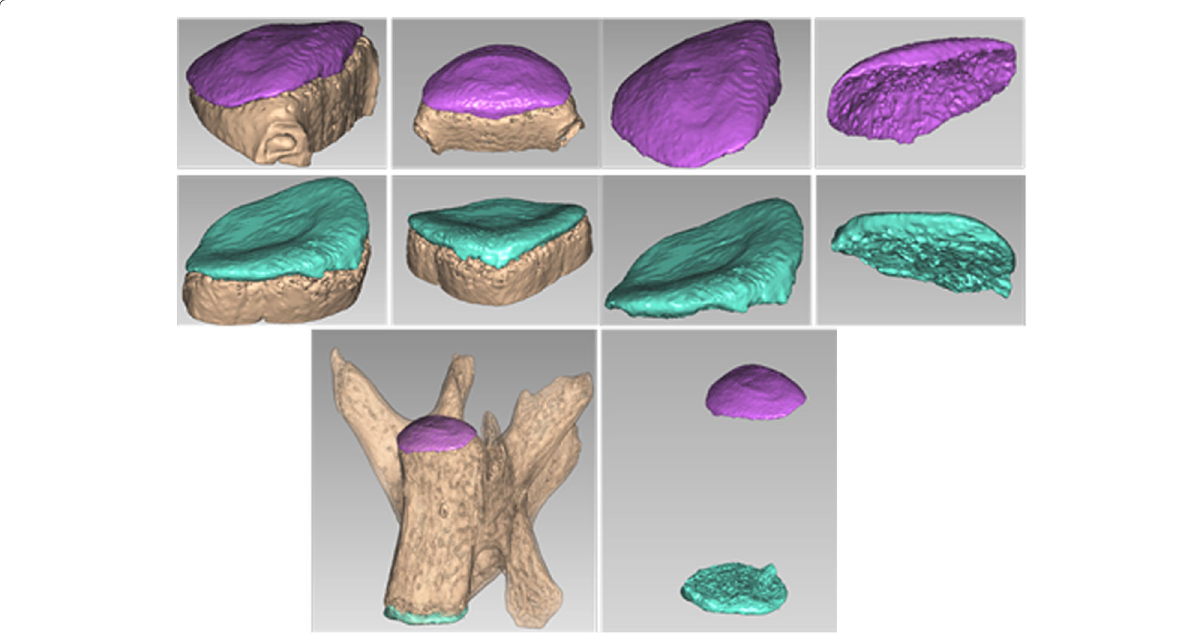
Fig. 13 The segmentation results in terms of reconstructed 3D models. The proposed method is employed to a randomly selected vertebra, the two successfully segmented endplates are shown in different